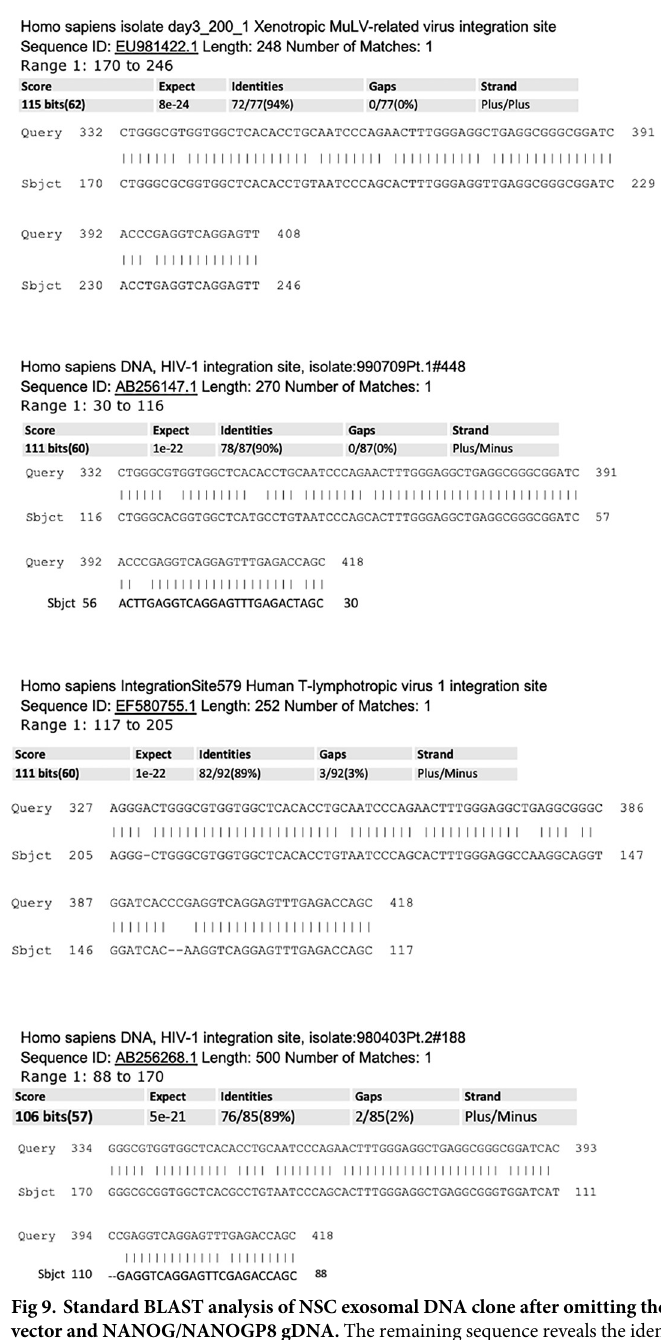
Fig 9. Standard BLAST analysis of NSC exosomal DNA clone after omitting the sequences for pCR4TOPO-TA vector and NANOG/NANOGP8 gDNA. The remaining sequence reveals the identities with various retroviral integration